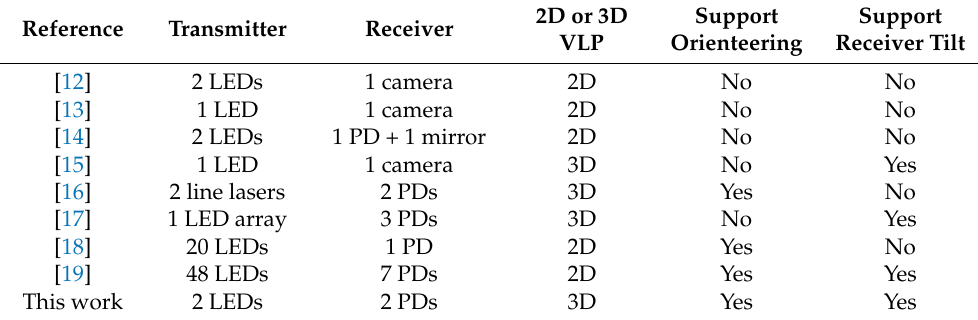
Table 1. Comparison between different VLP